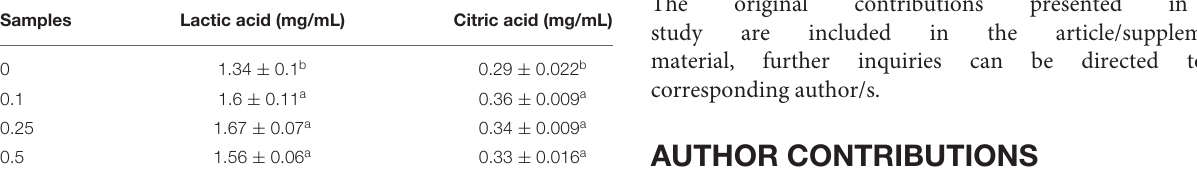
TABLE 3 | Content of lactic acid and citric acid in yogurt different concentrations (0, 0.1, 0.25, and 0.5 mg/ml) of procyanidin.